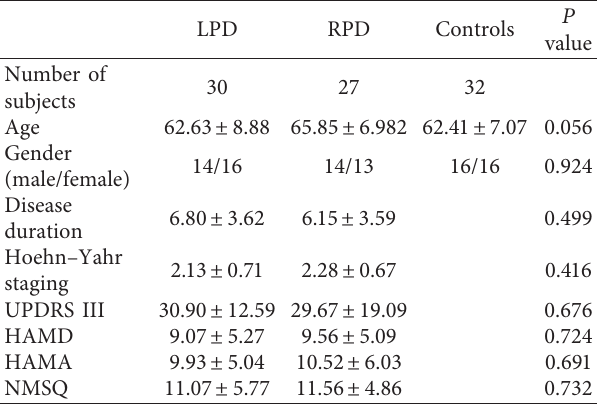
Table 1: Demographic and clinical characteristics of the PD pa- tients and